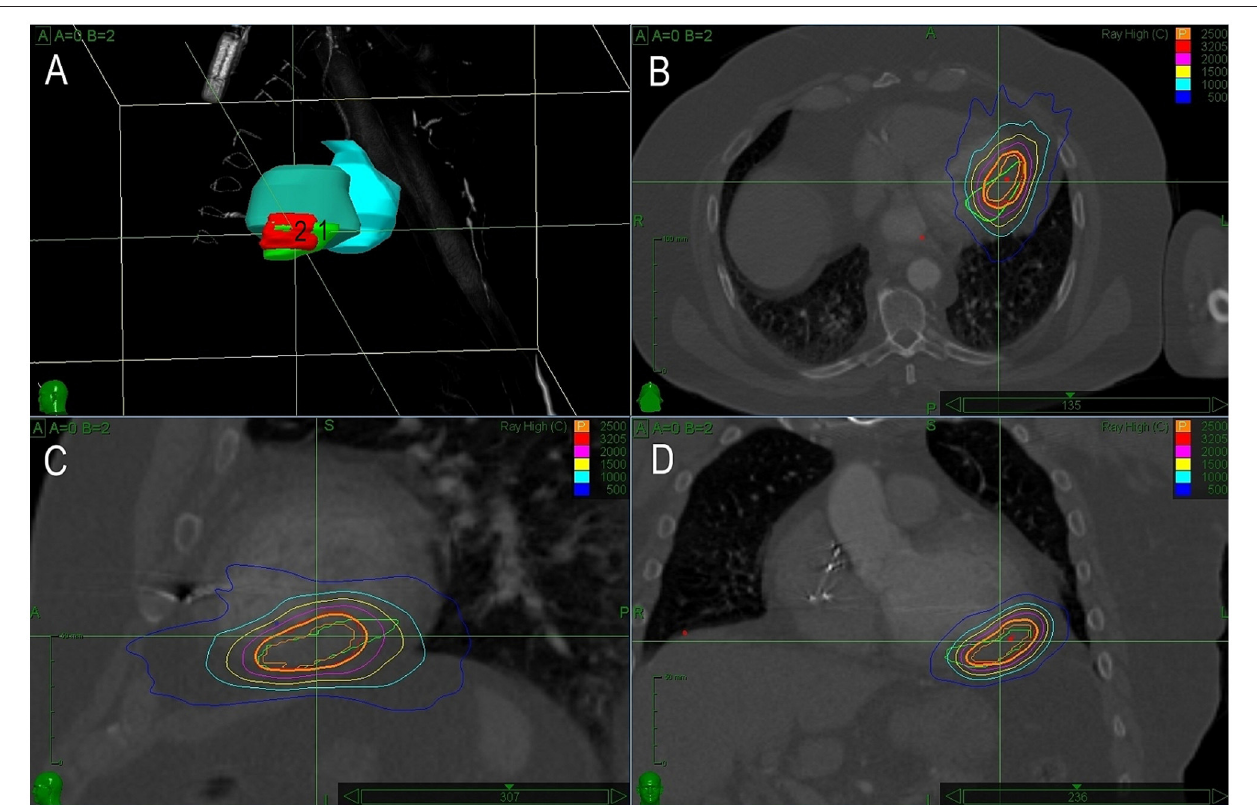
FIGURE 1 | A treatment plan for Case 1. (A) 3D reconstruction of planned treatment volumes for the first (1) and second (2) radiotherapy. (B–D) Depict sagittal, coronal, and axial views with isodose lines for both sessions of radiotherapy (green line shows target volume for the first and red for the second session). In this case, there is a significant overlap of both treatment volumes caused by inaccuracy in the planning of the first